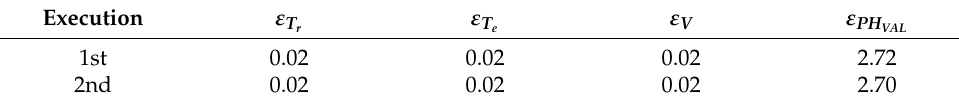
Table 4. Statistics for M 3